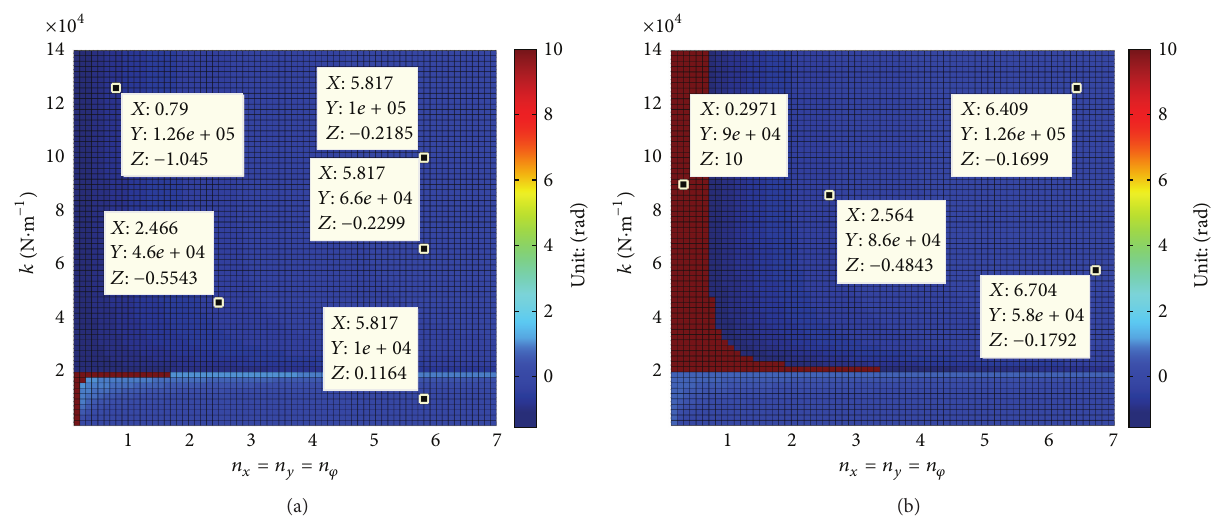
Figure 3: Stable phase difference with theoretical computation for (a) ℓ 1 = 0.6 [ m ] , ℓ 2 = 0.5 [ m ] , 𝛽 1 = 5𝜋/6 , and 𝛽 2 = 46𝜋/225 ; (b) = 0.4 [ m ] , ℓ = 0.4 [ m ] , 𝛽 = 3𝜋/4 , and 𝛽 = 𝜋/4 . In this figure, coordinate X represents the value of frequency ration 𝑛 ℓ 1 2 1 2 coordinate Y represents the value of the connecting spring k ; coordinate Z represents the value of stable phase difference 𝛼 ; 𝛼 = 10 [rad] shows that there is no stable phase.